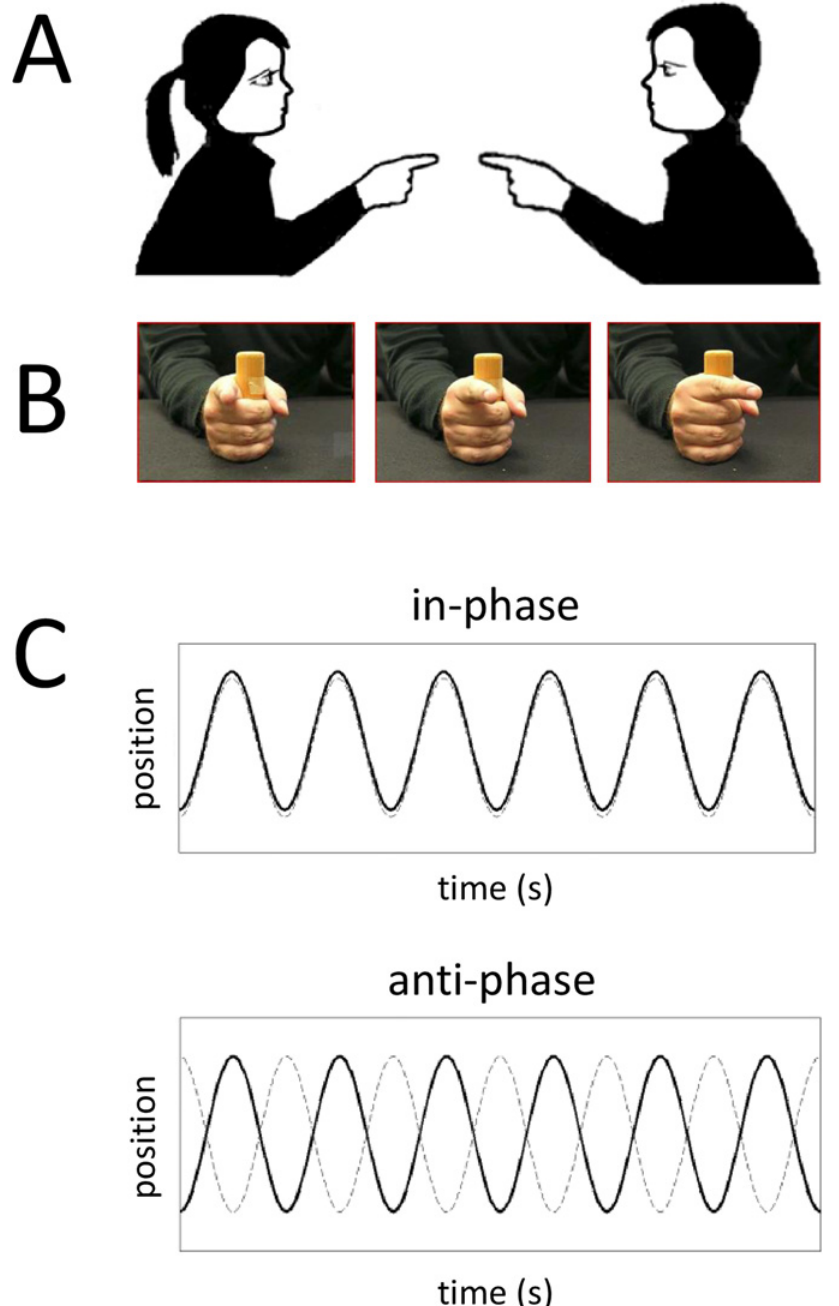
Fig 1. Coordination Paradigm. Typical inter-personal coordination paradigm (A) where visual information about finger movement is exchanged between the two partners (B), and the resulting finger movement is recorded as a function of time (C), here depicting in-phase and anti-phase coordination between participants. When in-phase, fingers move in the same direction, whereas when anti-phase, they move in opposite